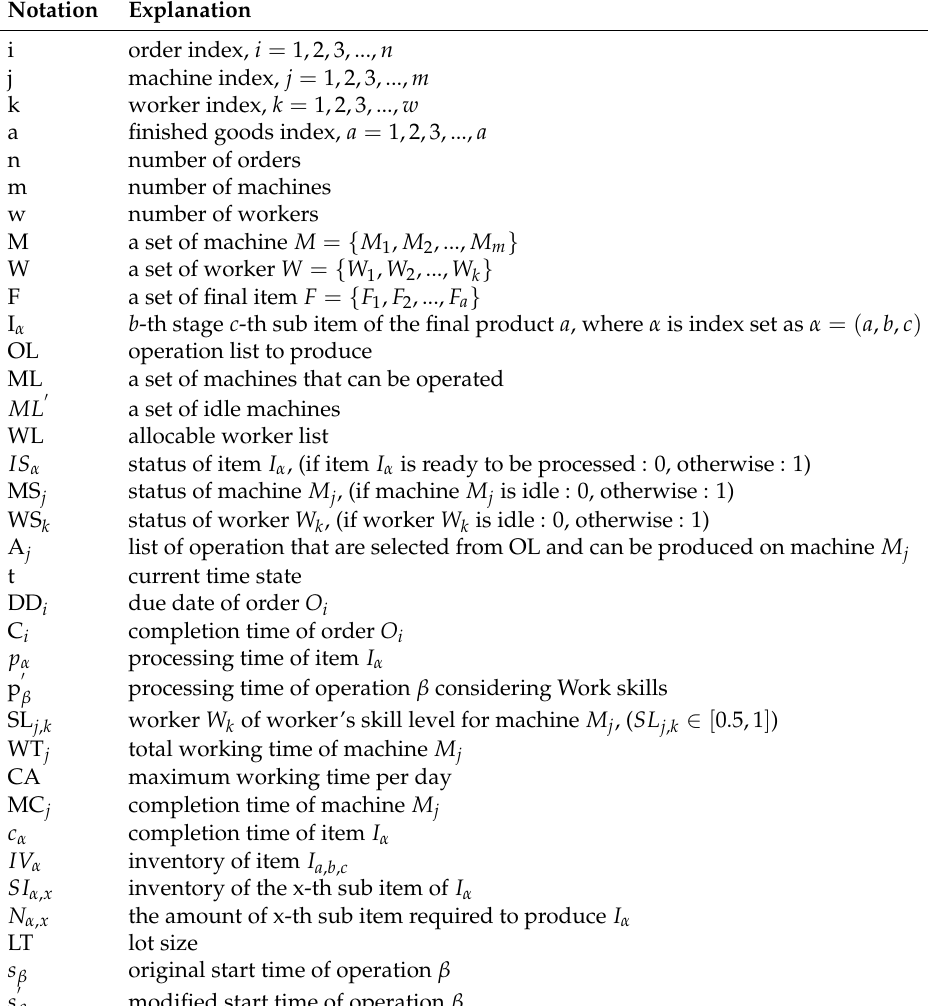
Table A1. Notations and